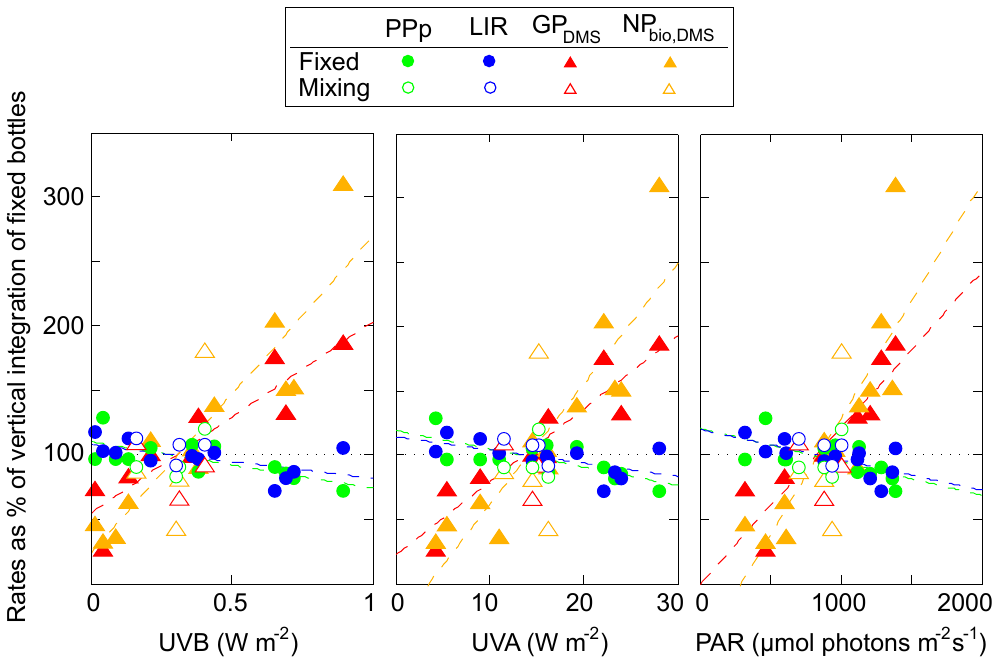
Fig. 7. Relationship between mean UVB, UVA and PAR irradiance during the incubations and particulate primary production (PPp), leucine incorporation rates (LIRs), gross DMS production (GP DMS ) and net biological DMS production (NP bio , DMS ). The rates have been normal- ized to the vertical integral of fixed-depth incubations (see text). The lines represent linear least squares fits to the fixed-depth incubations only (filled symbols). Vertically moving incubations (“mixing”, open symbols) have not been included in the regressions.